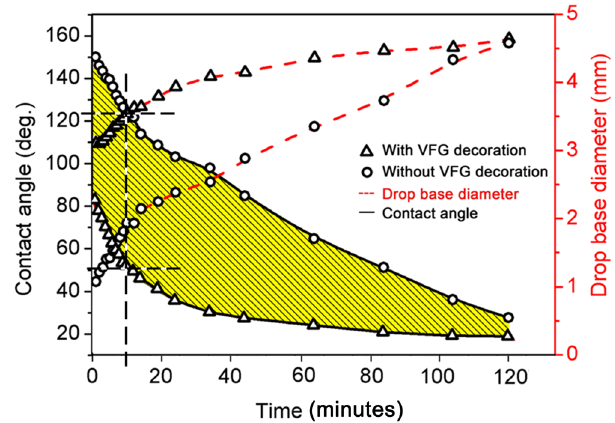
Figure 4. Contact angle (solid lines) and drop base diameter (dashed lines) as a function of time for AgCuTi alloy on SiO 2f /SiO 2 composites with and without VFG